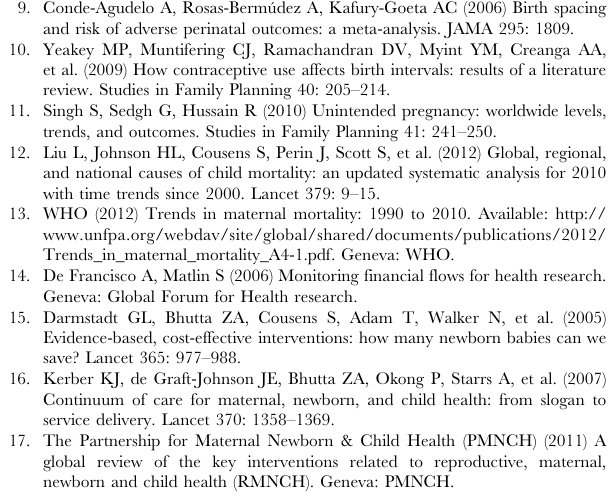
Table S1 Detailed CHNRI methodology for setting priorities in health research in Preconception Care. Table S2 Composition of the expert groups. All partici- pation in this CHNRI exercise was voluntary and carried out without specific funding support. All the experts who were invited to participate had a track record on research in maternal and child health and/or specific fields related to preconception care. Table S3 Template of scoring sheet. Table S4 The final ranked list of all 37 research questions with scores. Table S5 The actual scores given by technical experts to each of the research questions for each of the priority setting